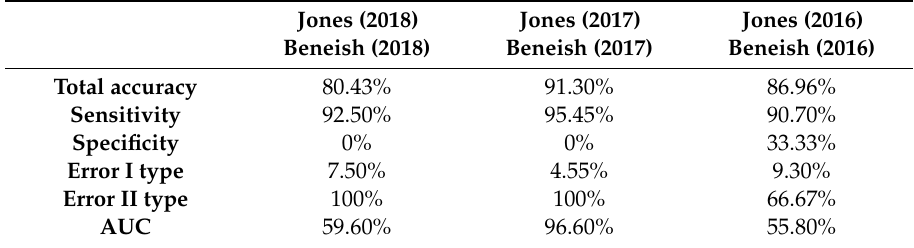
Table 8. Classification of